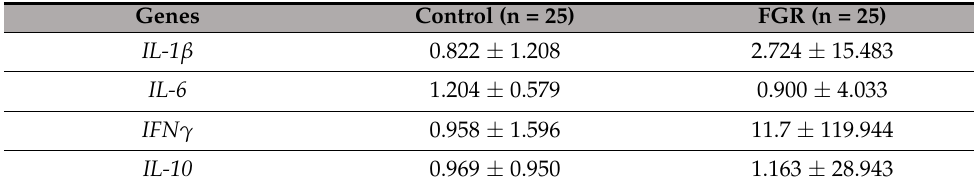
Values of all mRNA gene expressions relative to the combination of the two endoge- nous control genes, 18S rRNA and GAPDH , are presented as median ± IQR. IQR refers to inter-quartile range, a measure of statistical dispersion/ spread of the